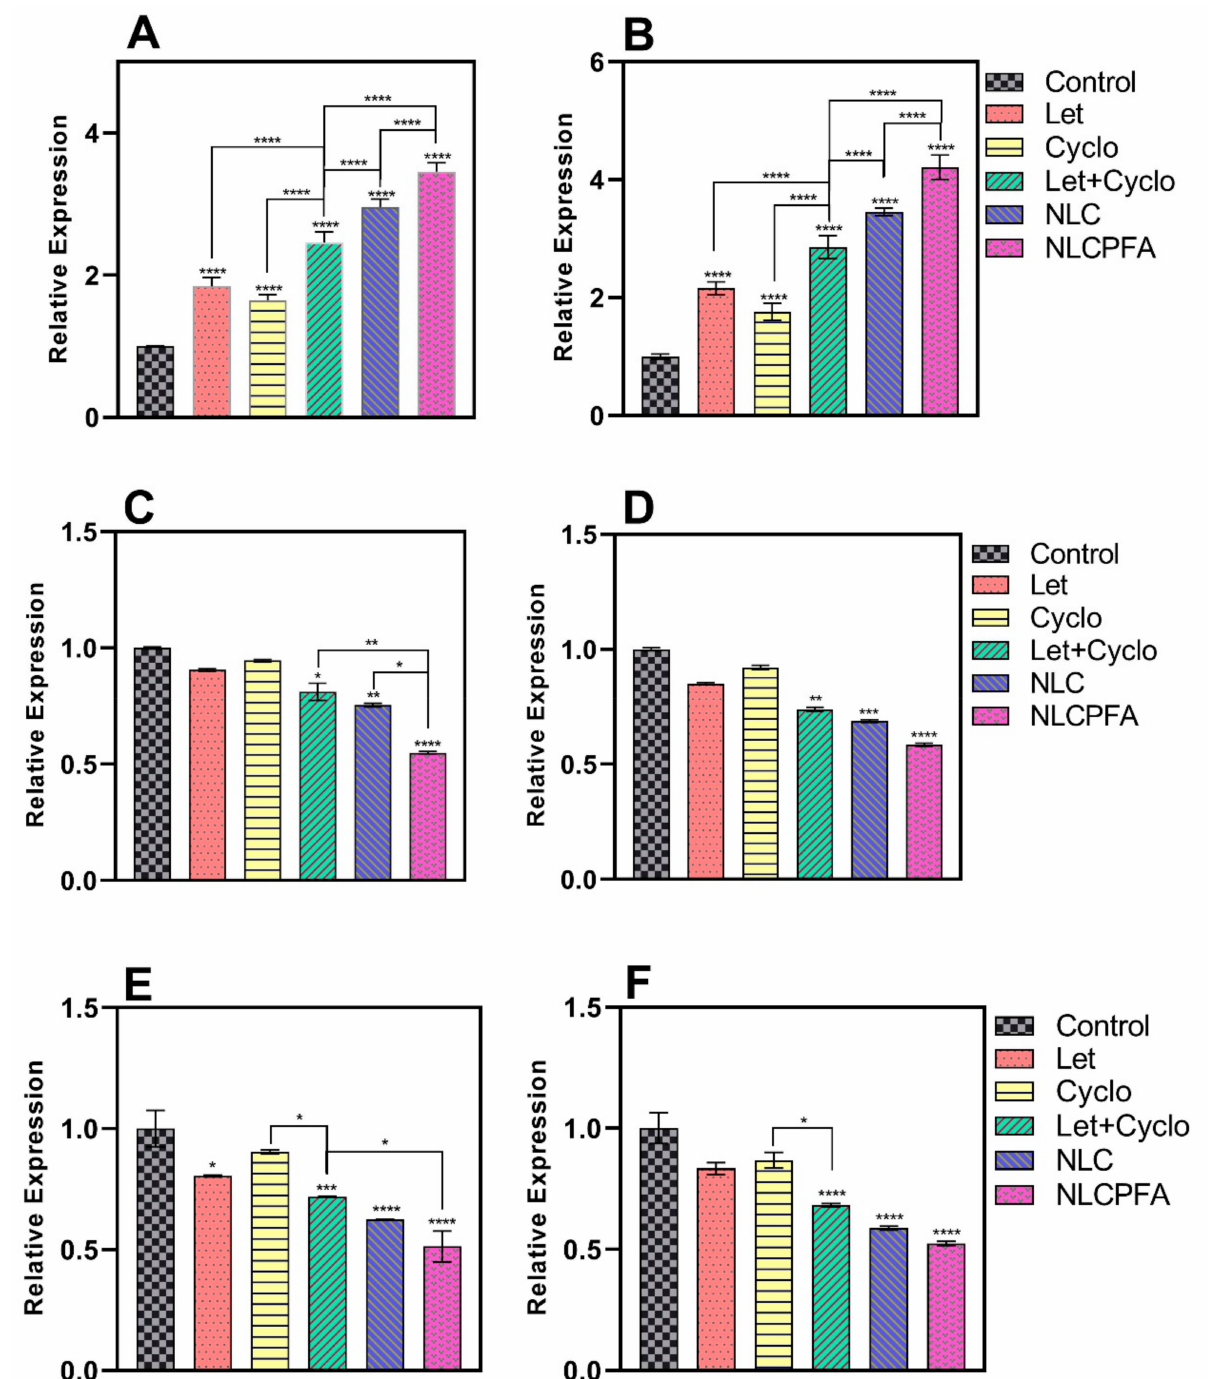
Figure 4. The expression level changes of ( A ) caspase-3 ; ( B ) caspase-9 ; ( C ) cyclin-D ; ( D ) cyclin-E ; ( E ) MMP-2 ; ( F ) MMP-9 genes in MDA-MB-231 cancerous cell line after 72 h treatment by co-loading Let and Cyclo in different niosomal formulations at their IC 50 concentration (* p < 0.05, ** p < 0.01, *** p < 0.001, and **** p <